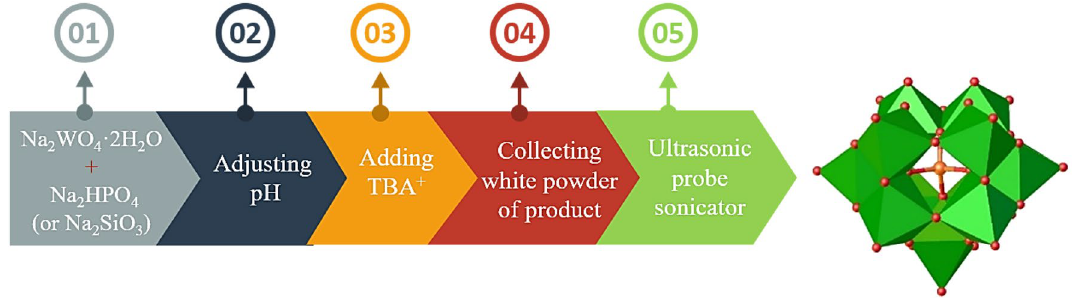
Figure 1. The illustration of the preparation route of nano-sized mono-lacunary Keggin anion. Color code = W: green polyhedral, P or Si: orange, and O: